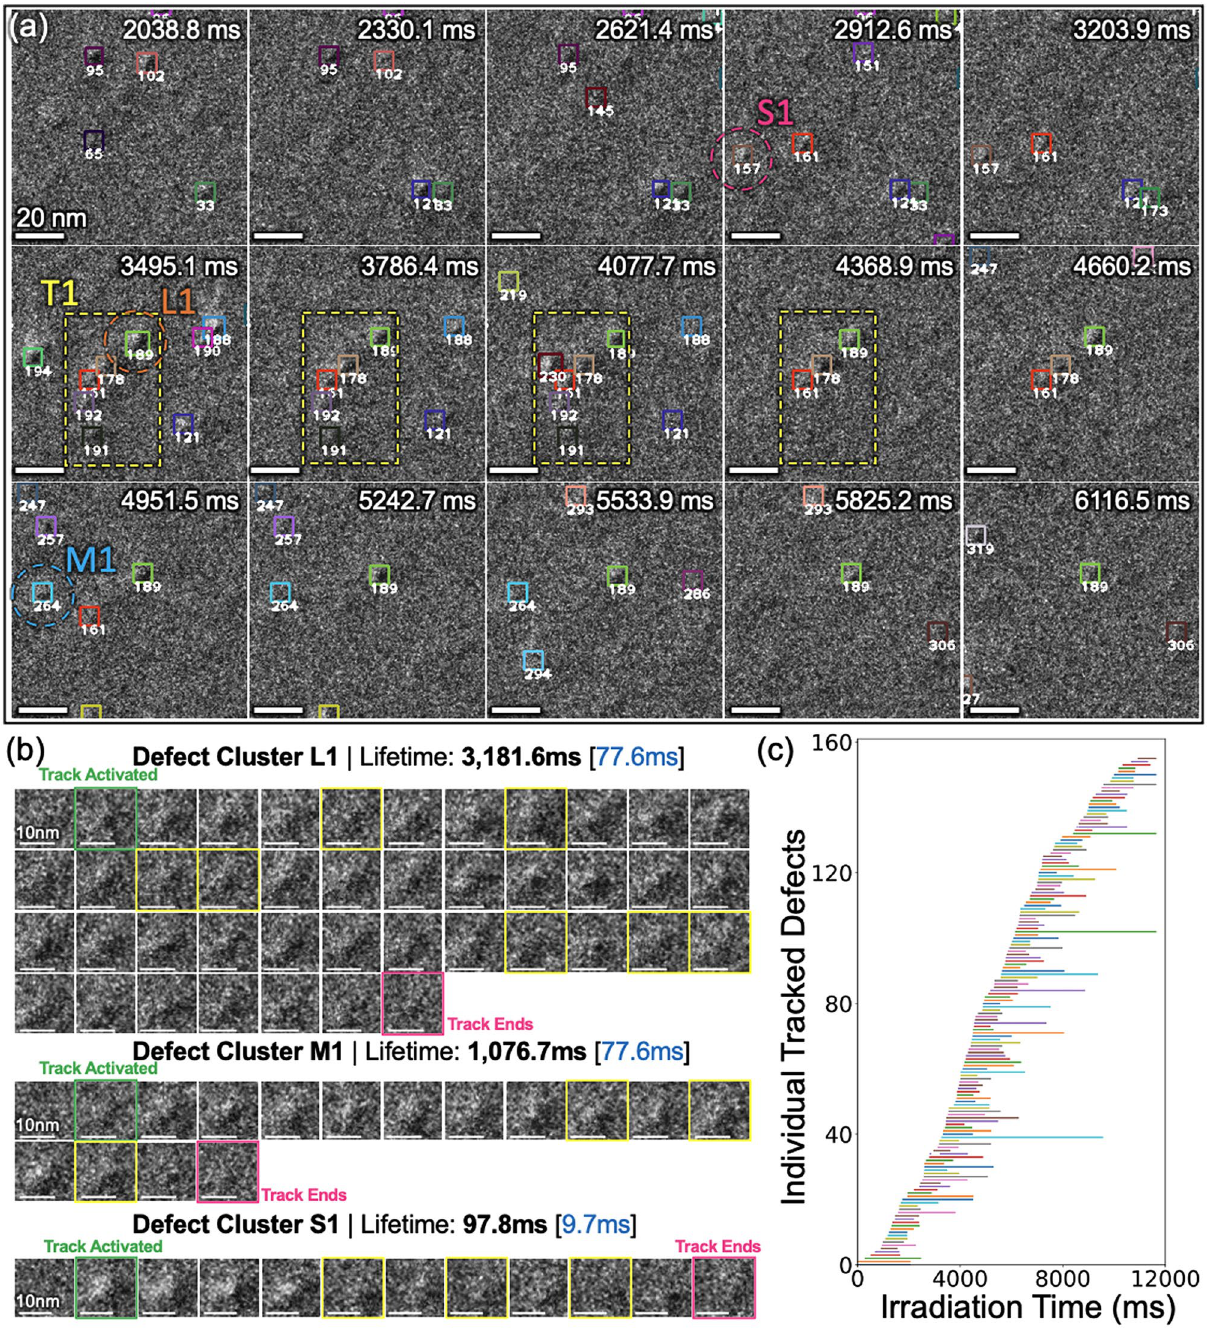
Figure 6. Visualization of the DefectTrack’s multi-object tracking performance on a representative test set. ( a ) Cropped 256 × 256 video frames from the DefectTrack prediction on the test set with a time interval of 291.3 ms (30 frames). The tracked defect clusters are marked with a bounding box and unique tracking IDs in the video frames. The bounding box color is encoded based on its tracking ID. ( b ) Representative example of individual defect clusters tracked by the DefectTrack . The time interval between frames is indicated by blue text inside the bracket. ( c ) DefectTrack predicted defect cluster tracks. The start of the bar indicates defect formation, the length is the lifetime, and the end of the horizontal bar marks the annihilation of defect clusters during in-situ irradiation. Note that only defect clusters with a lifetime greater than 600 ms are shown here for